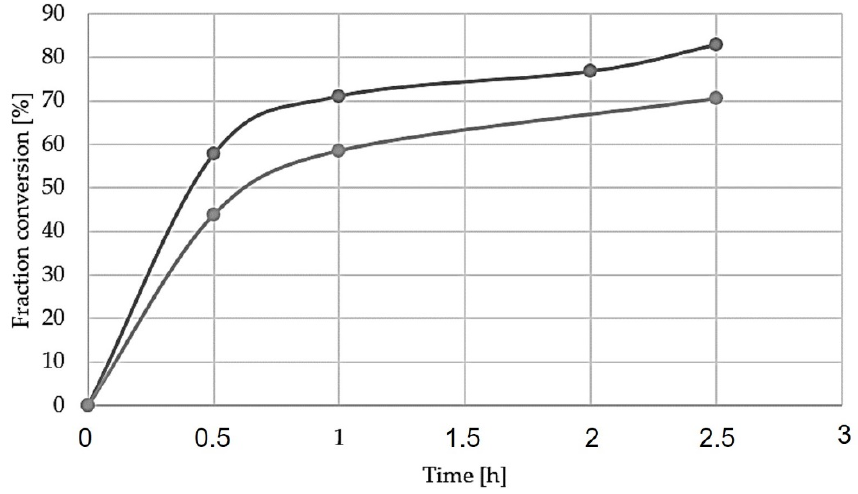
Figure 12. Fraction conversion of hematite to metallic iron as a function of time.